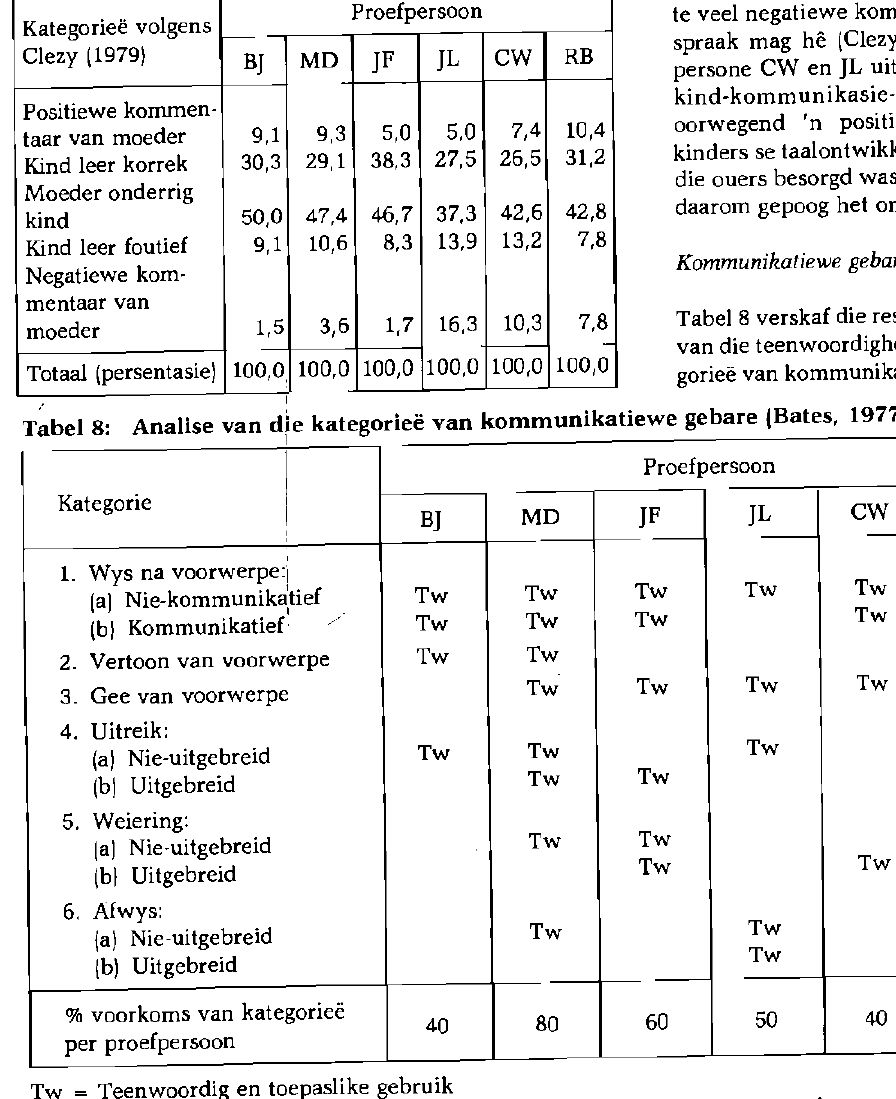
Tabel 7: Resultate van die moeder -kind-kommuni- sie-interaksie